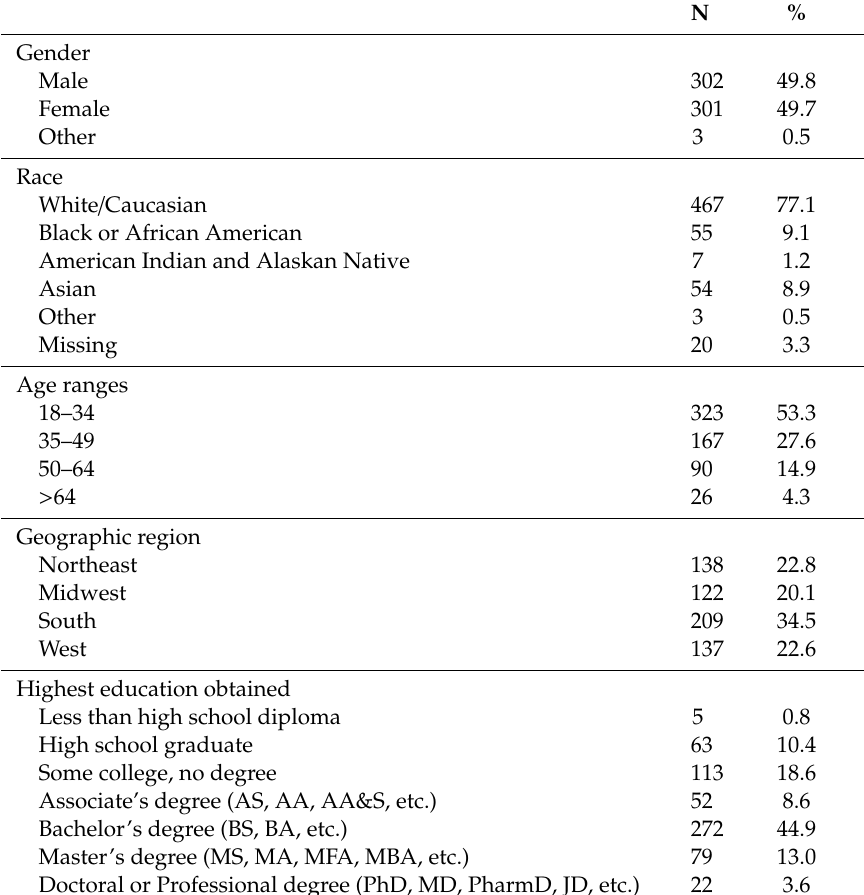
Table 1. Demographic characteristics of the sample